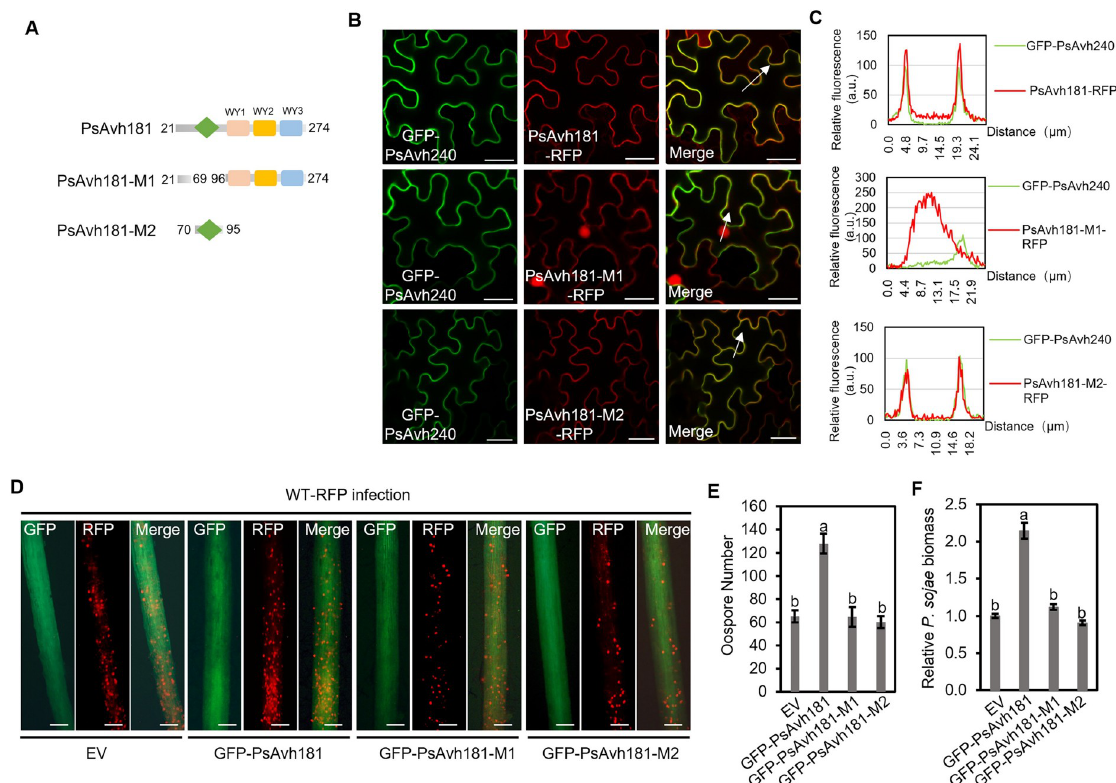
Fig 3. Plasma membrane localization of PsAvh181 is required for virulence. (A) Schematic view of PsAvh181 and deletion mutants. (B) Subcellular localizations of C-terminal RFP-tagged PsAvh181 and the derived mutants. N-terminal GFP-tagged PsAvh240 was used as a plasma membrane localized marker protein. Scale bars, 20 μ m. (C) Fluorescence analysis of GFP-PsAvh240 co-express with PsAvh181-RFP, PsAvh181-M1-RFP or PsAvh181-M2-RFP in membrane transects (white arrowheads). y axis, relative fluorescence intensity of GFP or RFP; x axis, transect length ( μ m). (D) P . sojae infection in the soybean hairy roots expressing N-terminal GFP-tagged PsAvh181 or the mutants PsAvh181-M1 and PsAvh181-M2. Scale bars, 0.2 mm (E) Quantification of oospores in the infected soybean hairy roots. Data are the mean ± SEM of five independent biological replicates. Different letters at the top of bars indicate significant differences ( P < 0.01; one-way ANOVA). (F) The relative biomass of P . sojae was determined by qPCR at 48 h after inoculation. Data are the mean ± SEM of five independent biological replicates. Different letters at the top of bars indicate significant differences ( P < 0.01; one-way ANOVA).